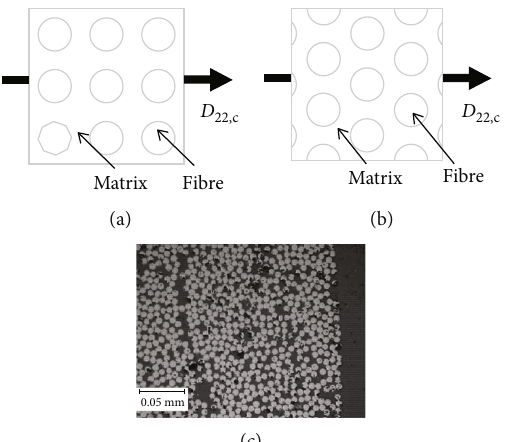
Figure 1: (a) Square array packing and (b) hexagonal array packing (c) 500 × magni fi ed optical microscope image of CFRP tendon edge.